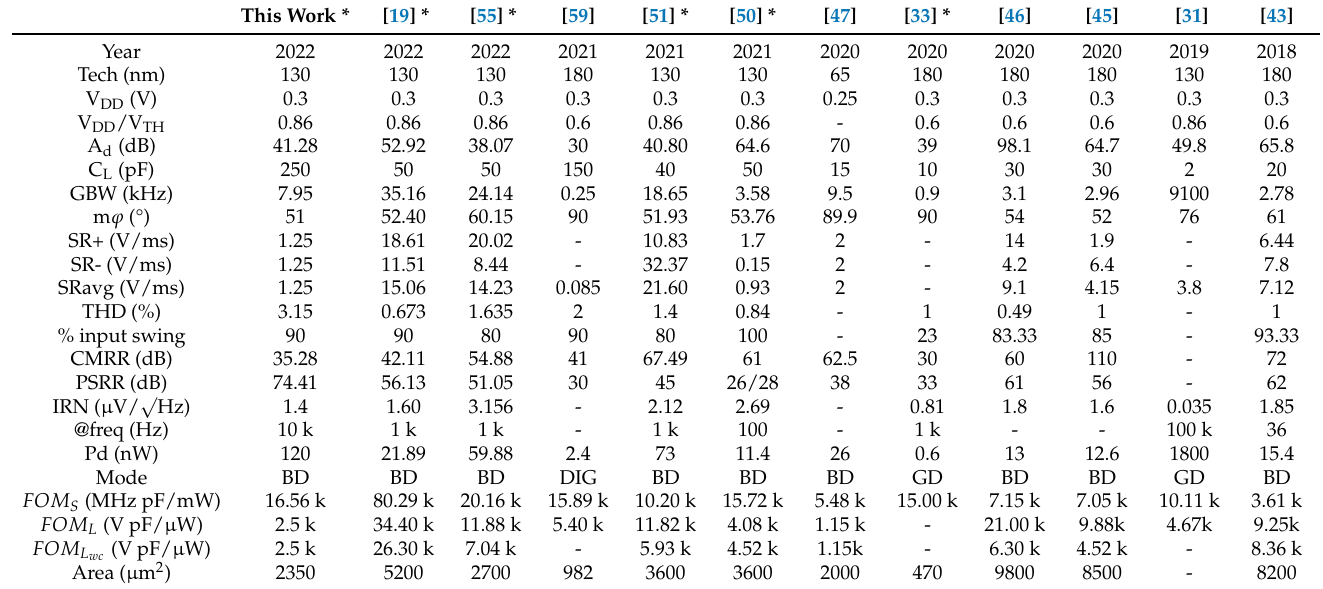
Table 5. Comparison with the